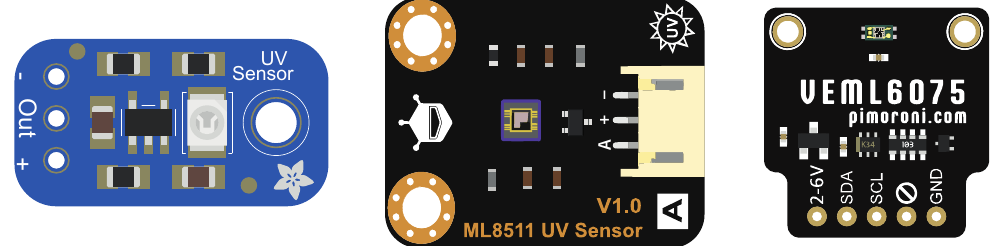
Figure 2. Boards integrating the chosen sensors: GUVA-S12SD UV-A ( left ), LAPIS ML8511 ( center ), and Vishay’s VEML6075 ( right